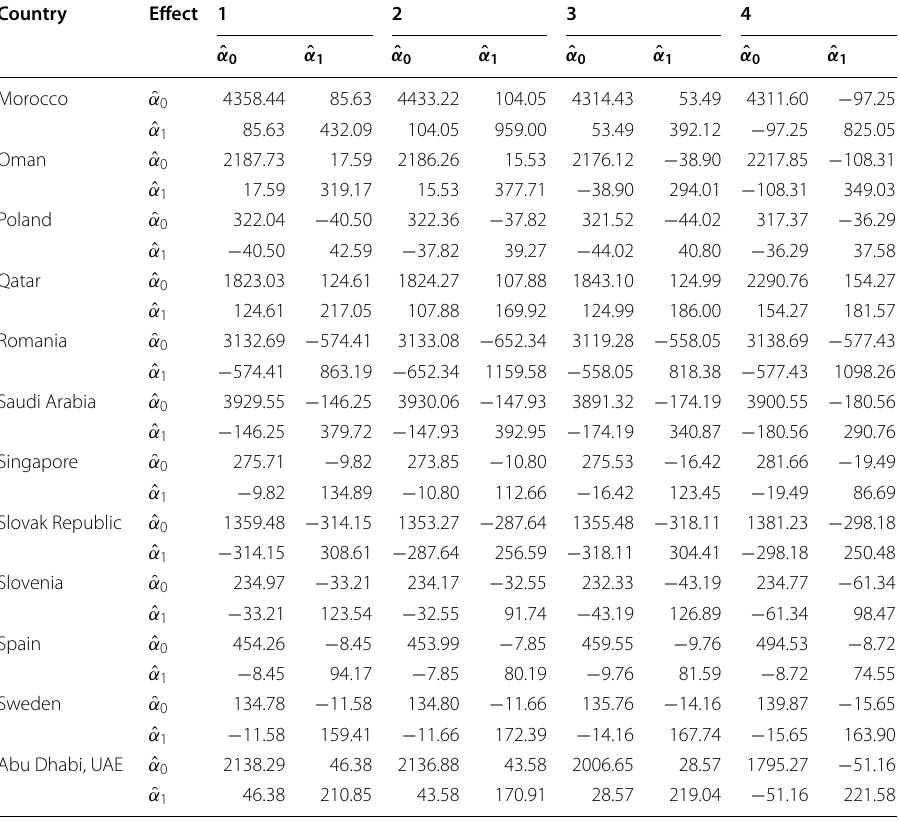
1, scaling model 1; 2, scaling model 2; 3, scaling model 3; 4, scaling model 4; ˆ α 0 , random intercept; ˆ α 1 , random slope of home resource for learning index